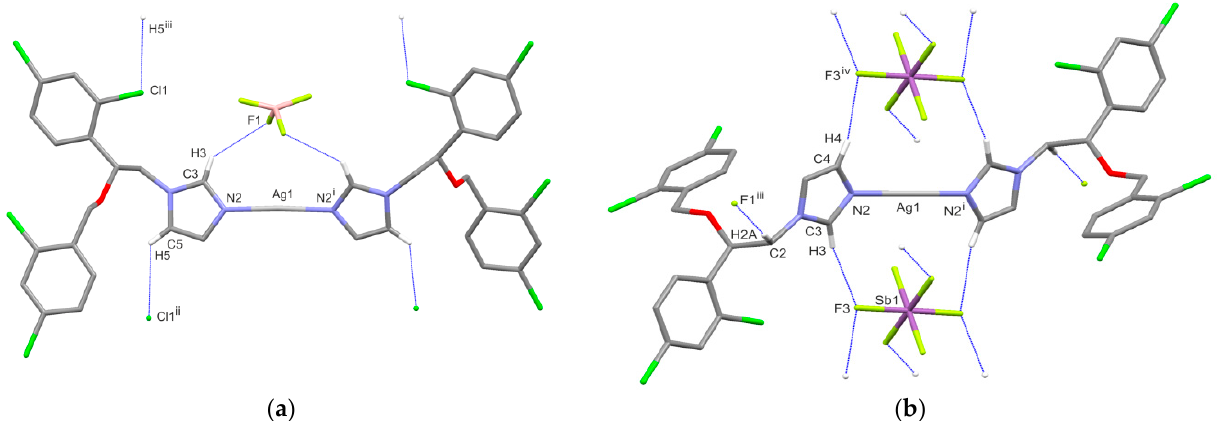
Figure 4. Hydrogen-bonding scheme in 3 ( a ) and 4 ( b ). In both cases, hydrogen atoms not involved in H-bonds are omitted for clarity. Symmetry codes: 3 (i) − x, y, − z + ½; (ii) − x, y − 1, z ; (iii) − x, y + 1, z ; 4 (i) − x + 1 , − y + 2 , − z + 1 ; (iii) − x + 1, − y + 1, − z + 1; (iv) x − 1, y , z .